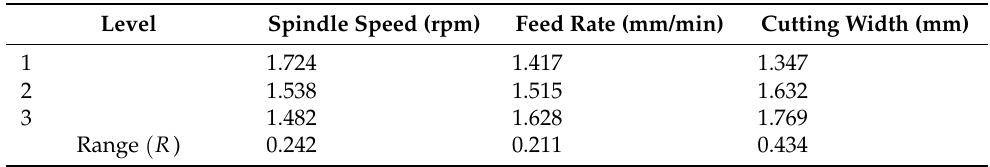
Table 8. Two-factors/four-levels and one-factor/three-levels orthogonal experimental significance analysis of average length of tearing L